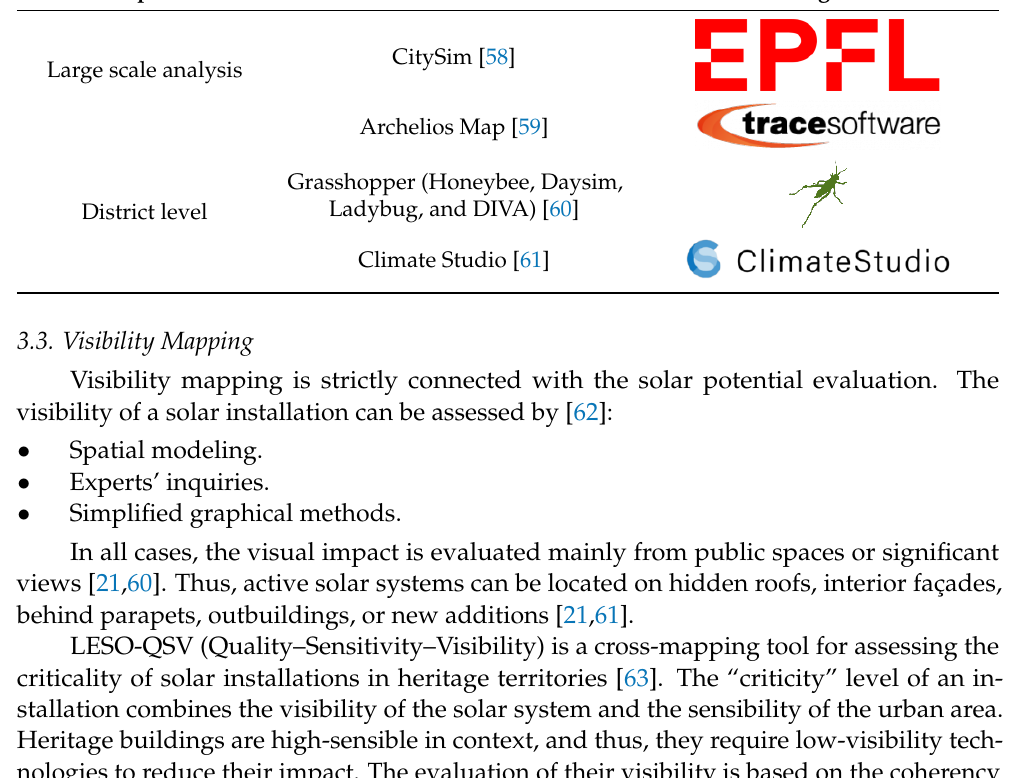
Table 5. Visual criticality and solar radiation maps to be used on heritage contexts (Source: Author’s elaboration from [62]).